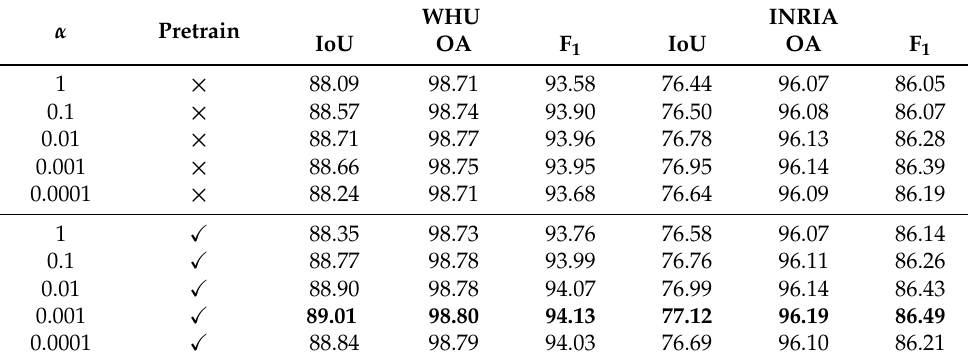
Table 8. Accuracy of our method SST ( R 18, S 4 ) with different loss balancing factors α , and w/ or w/o using